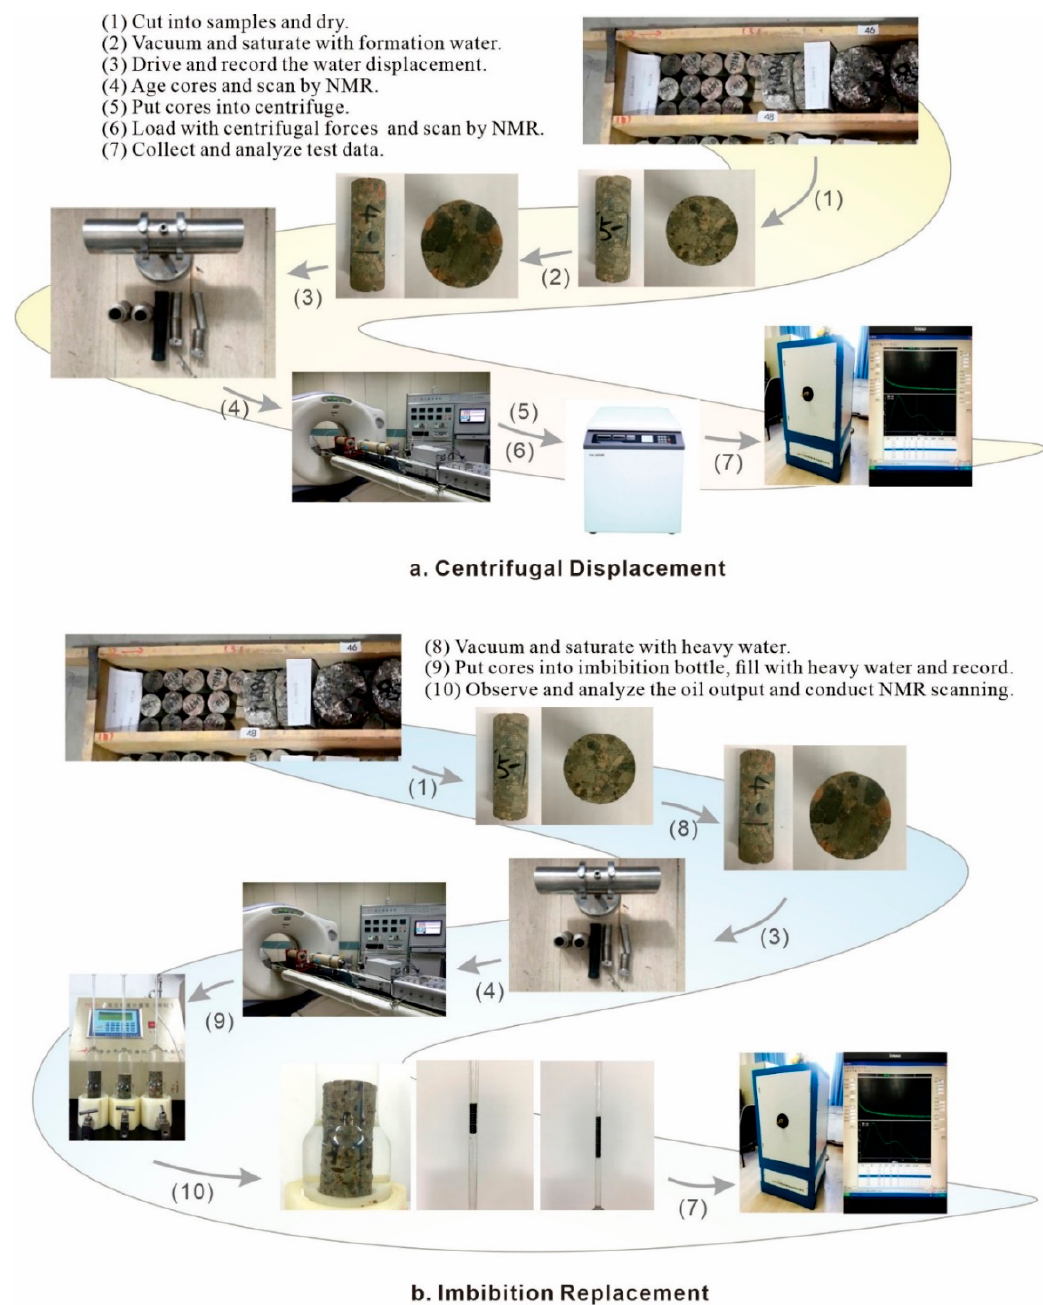
Figure 5. ( a ) Flow Chart of Centrifugal Displacement Experiment; ( b ) Flow Chart of Imbibition Replacement Experiment.